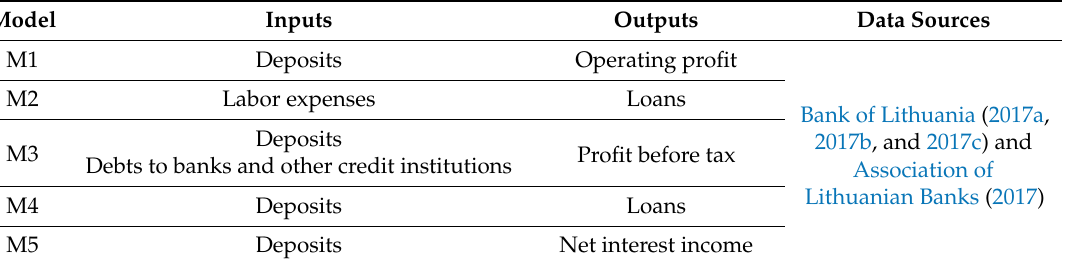
Table 1. DEA models with different input-output